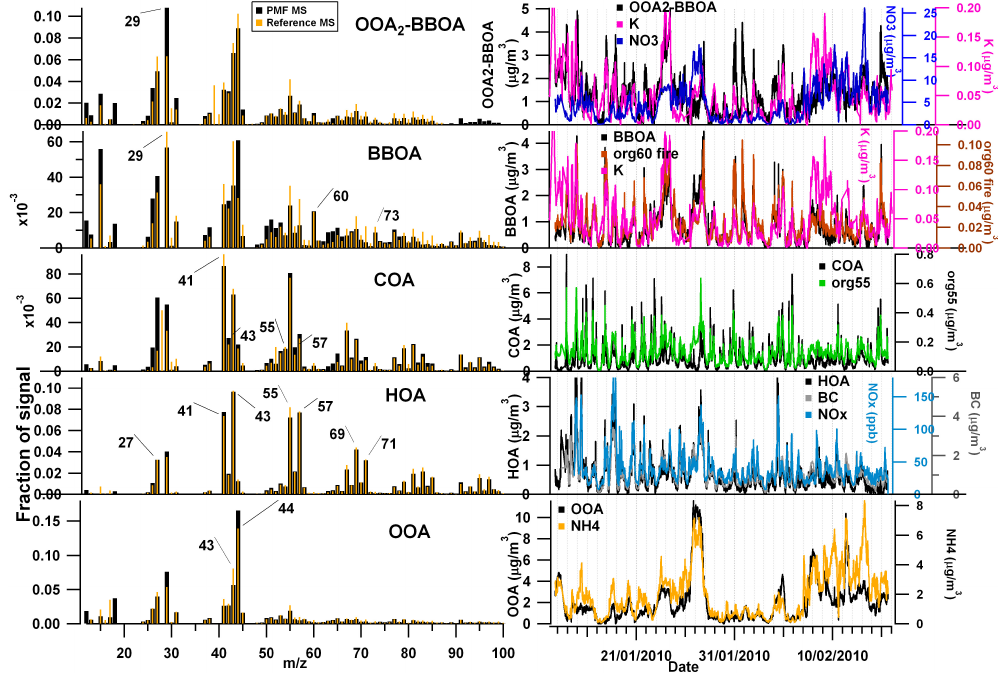
Fig. 5. PMF results: time series and mass spectral comparisons (LHVP site). The COA reference spectrum is calculated as the mean of all cooking emissions spectra measured by He et al. (2010), and the OOA 2 -BBOA spectra is from DeCarlo et al. (2010), and other reference spectra are taken from Ng et al.